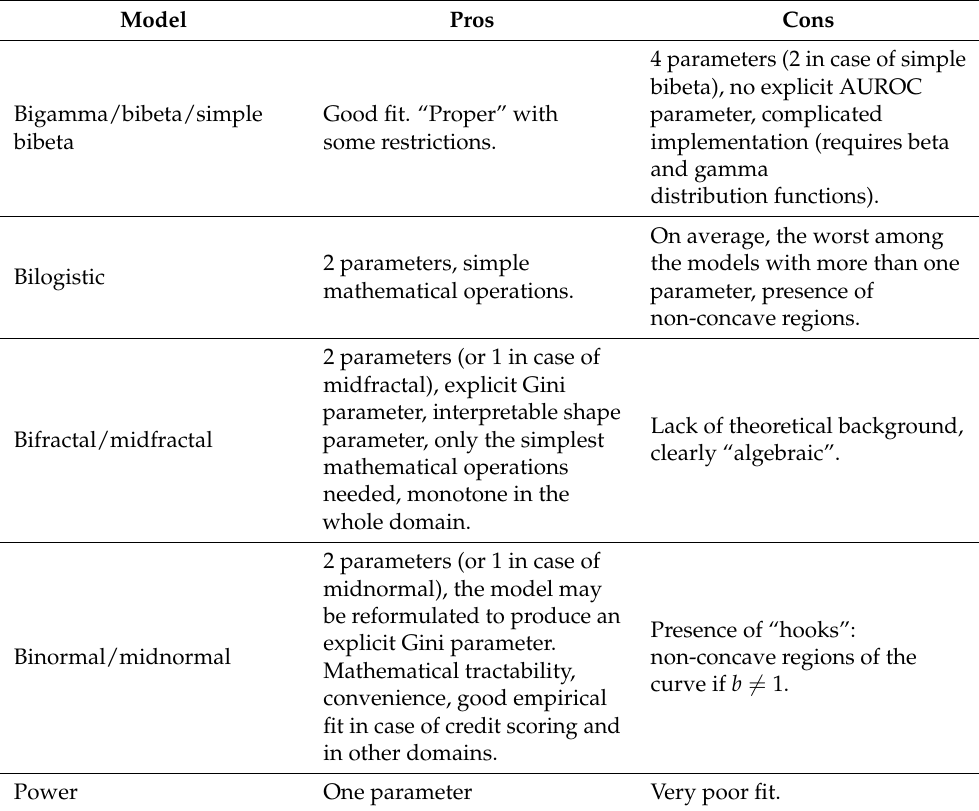
Table 3. ROC curve models—pros and